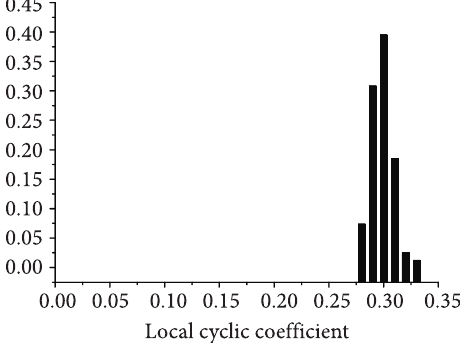
Fig. 5. Local cyclic coefficient distribution of network